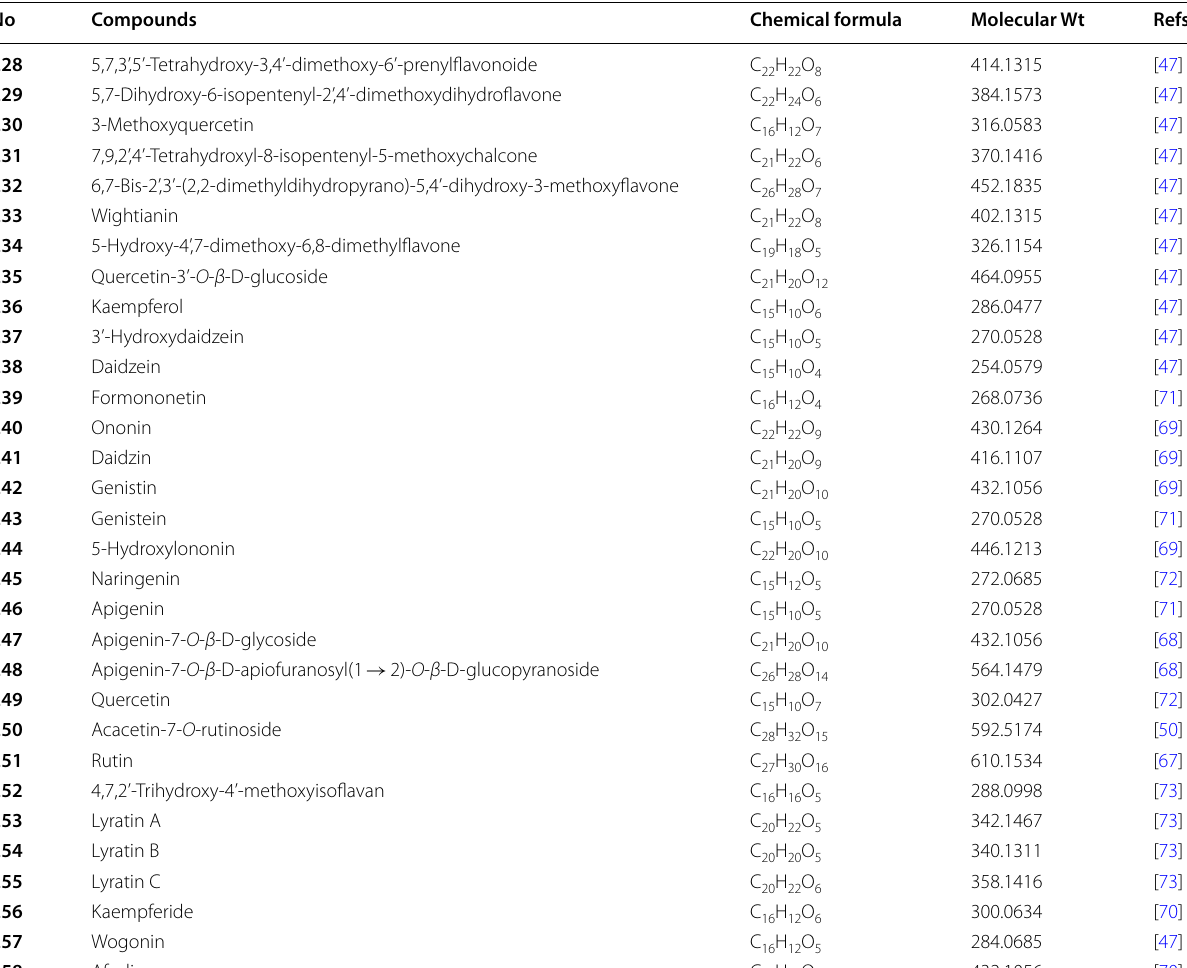
Table 11 Flavonoids isolated from S.